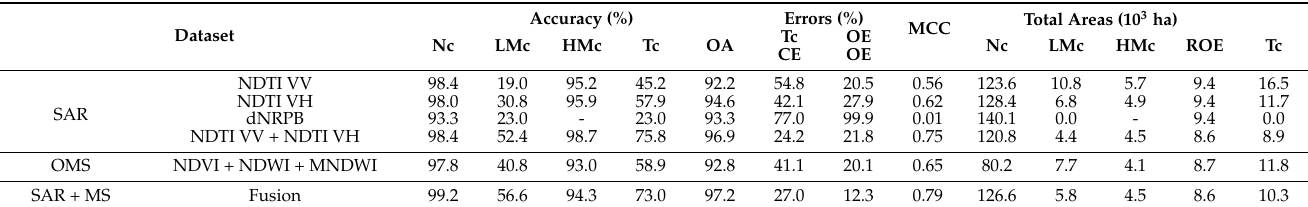
Table 7. Summary of the confusion matrix parameters and Matthews Correlation Coefficient (MCC) obtained for the Mondego flood, in comparison to the Reference Observed Event (ROE) (Nc—no changes; LMc—low-magnitude changes; HMc—high-magnitude changes; Tc—total changes;